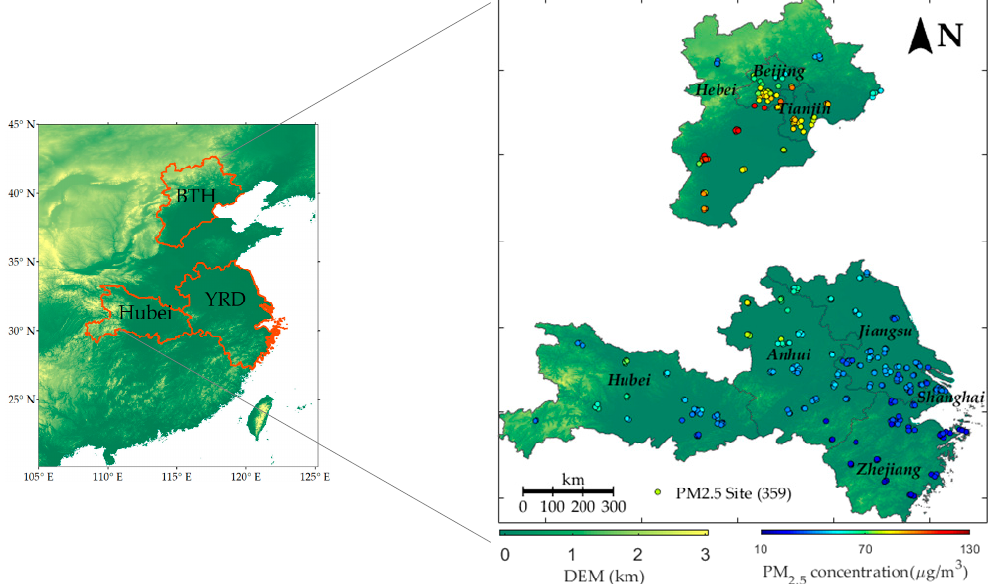
Figure 1. Study areas and spatial distribution of mean PM 2.5 concentration.